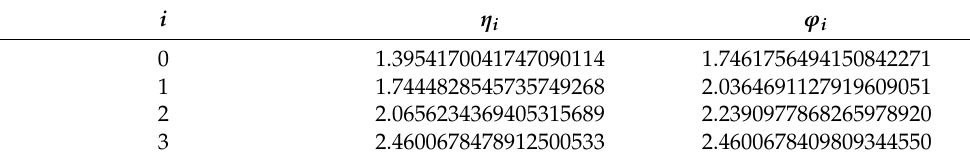
Table 6. Values of η i and ϕ i (in radians) for Example